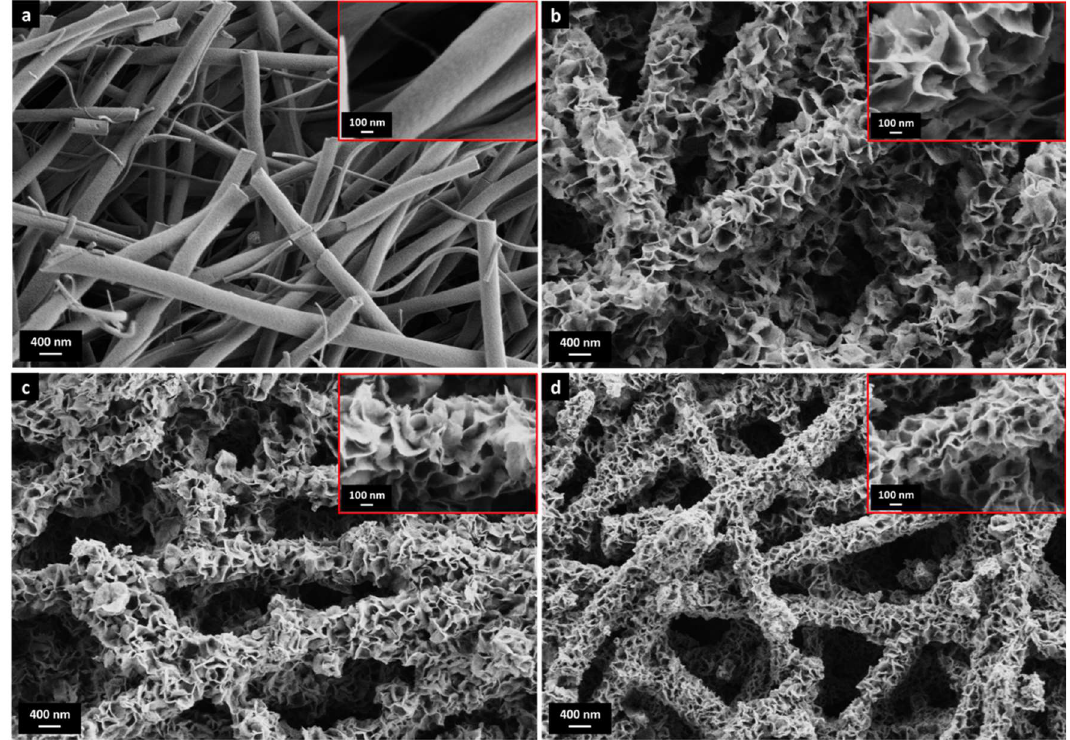
Figure 1. HRSEM images of ( a ) AlNFs and ( b – d ) AlNFs decorated by 7 wt% Zn in the form of ZnO (sample AlNFs-Zn-7), 7 wt% Cu in the form of CuO (sample AlNFs-Cu-7), and 7 wt% Zn&Cu in the form of ZnO&CuO (AlNFs-1Cu2.3Zn-7) in a wt. ratio of 2.3 Zn/Cu. The inserts are larger magnifications.